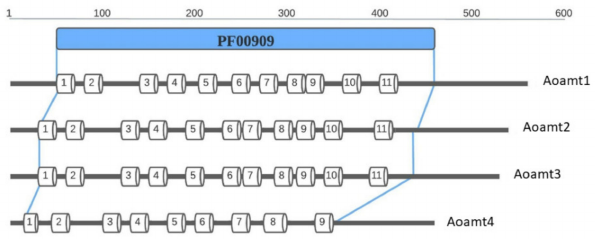
Figure 1. Transmembrane domains of Aoamt1, Aoamt2, Aoamt3, and Aoamt4 of A. oryzae BCC 7051. The positions of putative transmembrane (TM) helices and topology were assigned by using the TMHMM2.0 program